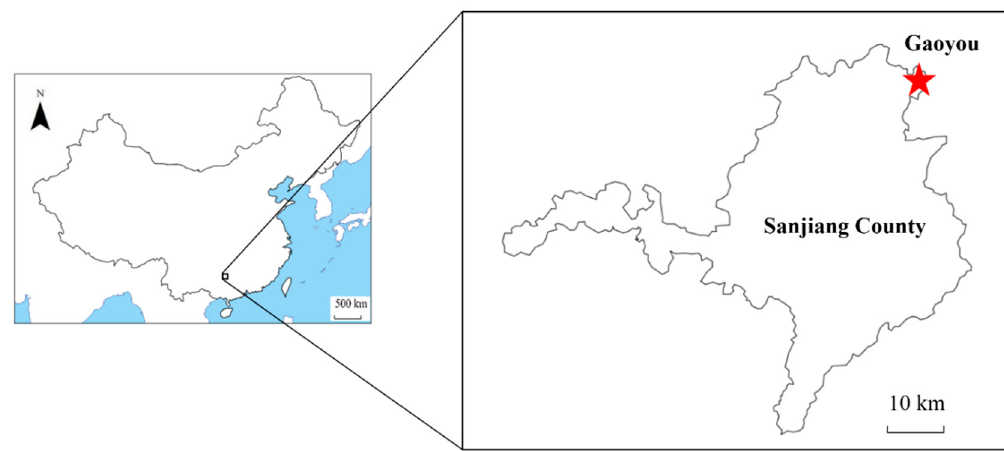
Figure 2. Gaoyou study area.